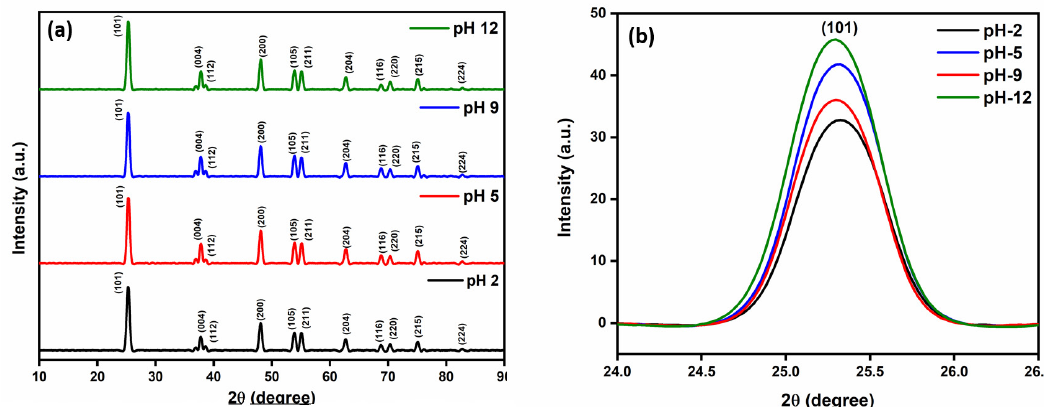
Fig. 1. (a) XRD spectra of TiO synthesized at various pH conditions, (b) dominant peak of XRD spectra 2 Table 1. Ratio of initial and final product with time Titanium Tetrachloride Ethylene Glycol Weight of the final Samples Urea (g) (l) (ml) product(g)